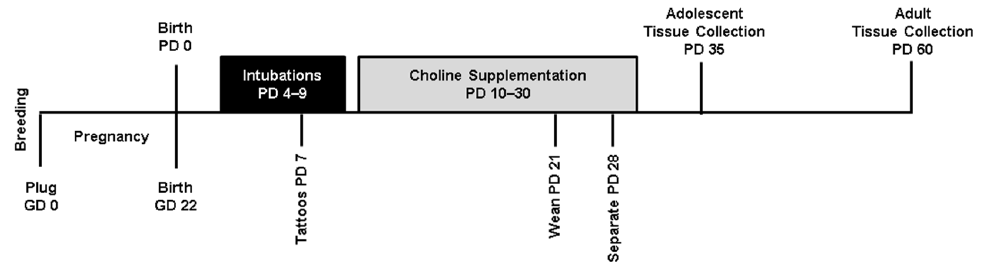
Figure 1. Timeline of experimental procedures. GD: gestational day, PD: postnatal day.